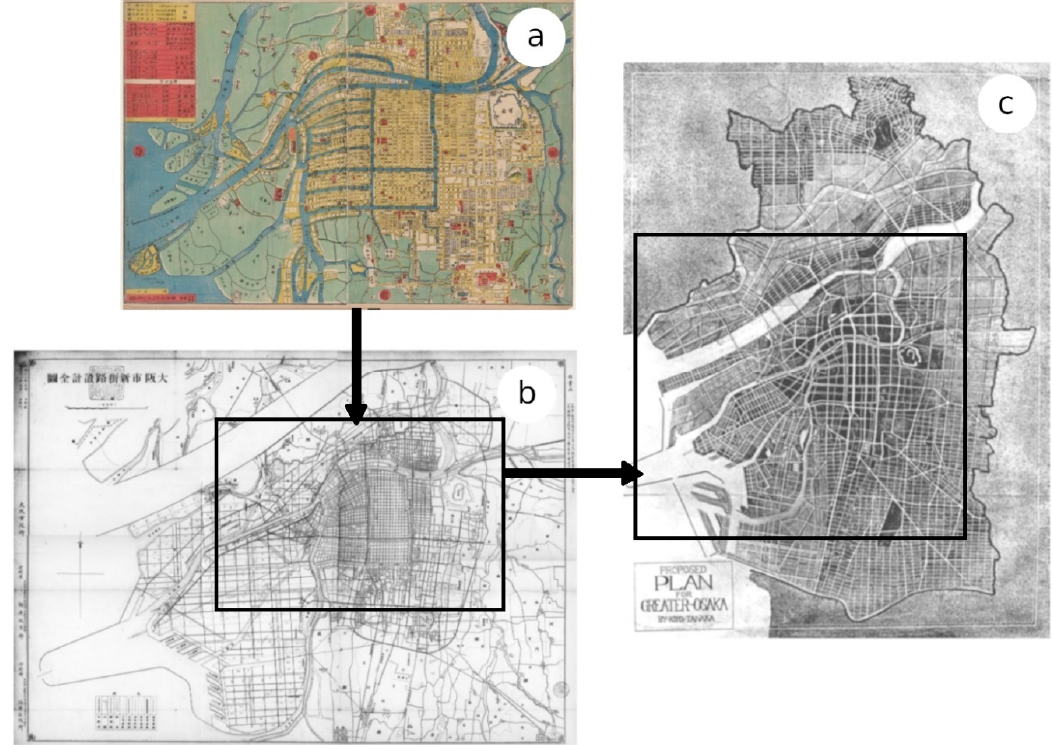
Figure 2. The integrated and comprehensive plan for Greater Osaka. ( a ): Detailed map of the city of Osaka in the Meiji era, Sueyoshi. 1:12 500, gallica.bnf.fr/Bibliothèque Nationale de France . ( b ): Osaka’s Expansion Plan (1899), Digital Collection of National Diet Library, Japan. ( c ): Greater Osaka’s Expansion Plan (1925), Digital Collection of National Diet Library, Japan.